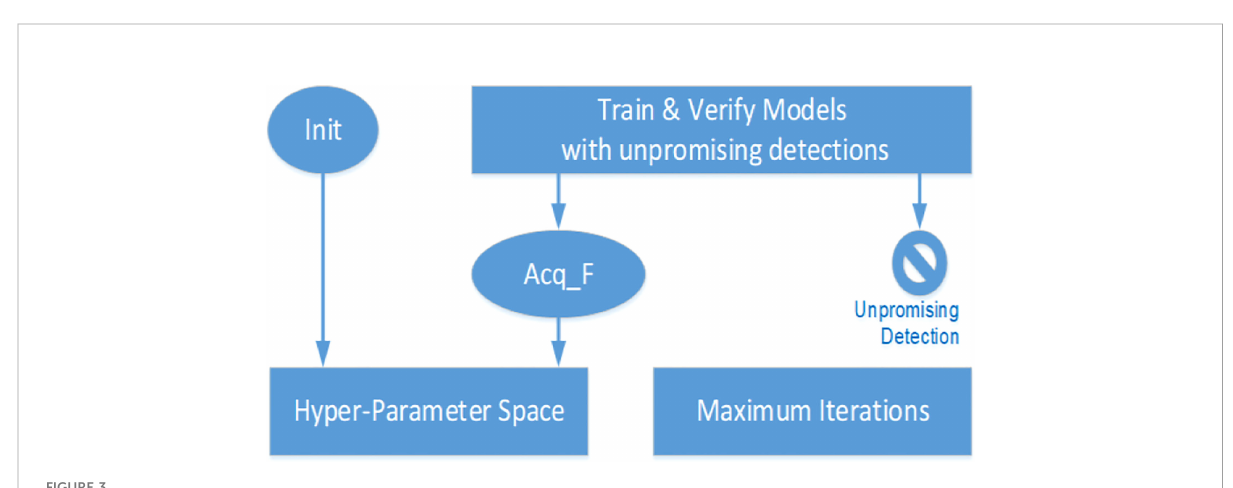
FIGURE 3 Dynamic quit conditions. Generation